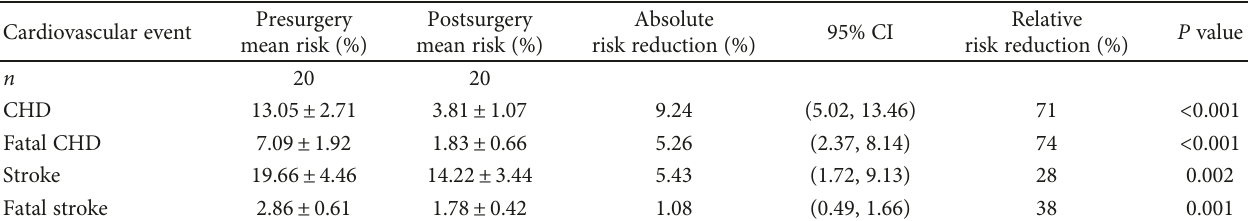
Table 3: Estimated 10-year cardiovascular risk before versus after RYGB surgery ( n = 20